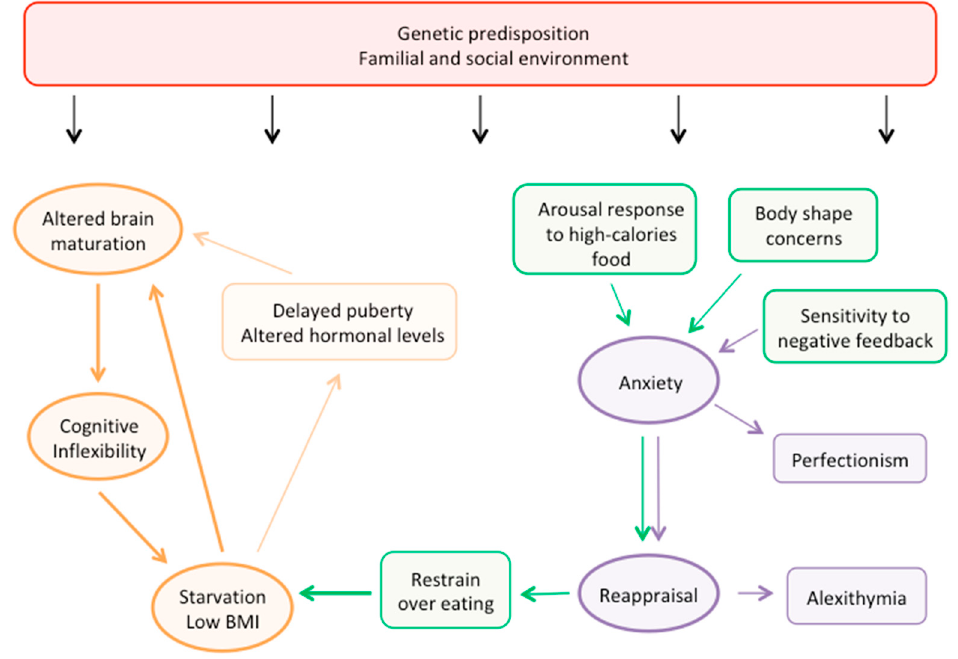
Figure 4. Pathogenic model of adolescent AN. The figure summarizes the pathogenic model of adolescent AN we propose, based on current fMRI findings in healthy and anorectic patients.